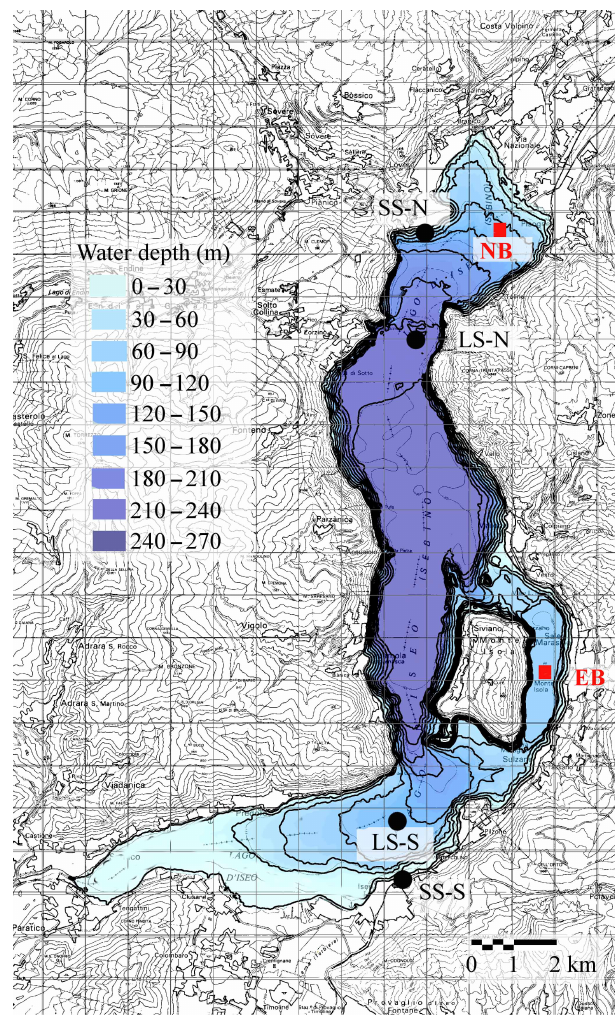
Figure 1. Contour of Lake Iseo bathymetry and isodepth lines at 30m spacing. The black dots show the measurement stations lo- cated on the shore (SS) and in the lake (LS), both north and south. The red squares indicate the two points at 98m in depth in the east- ern basin (EB) and 105m in the northern basin (NB) that are men- tioned in the